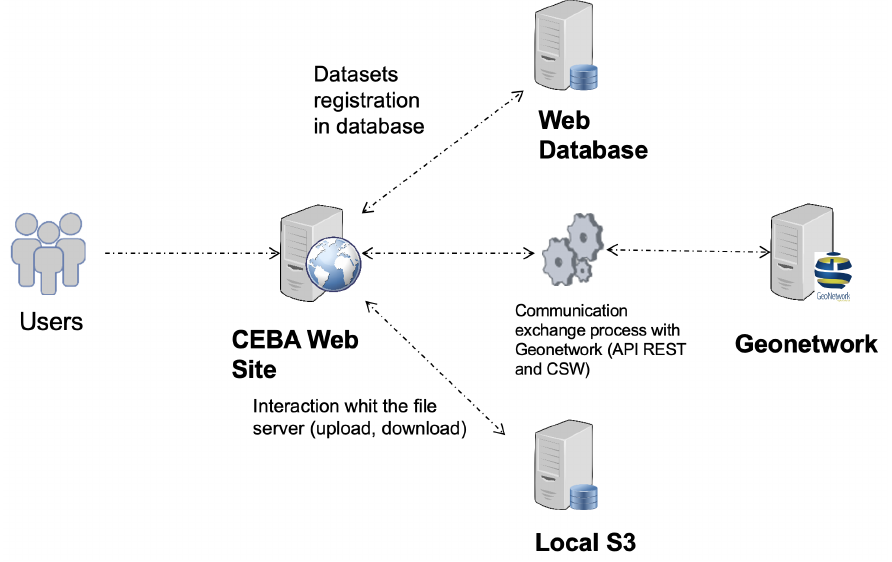
Figure 9. Flows between website and data